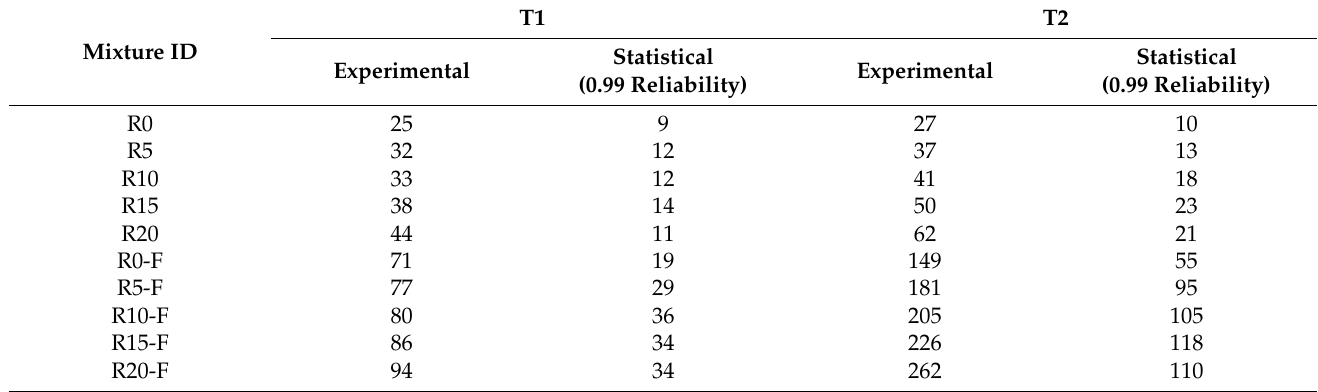
Table 5. Comparison of experimental value with statistical analysis